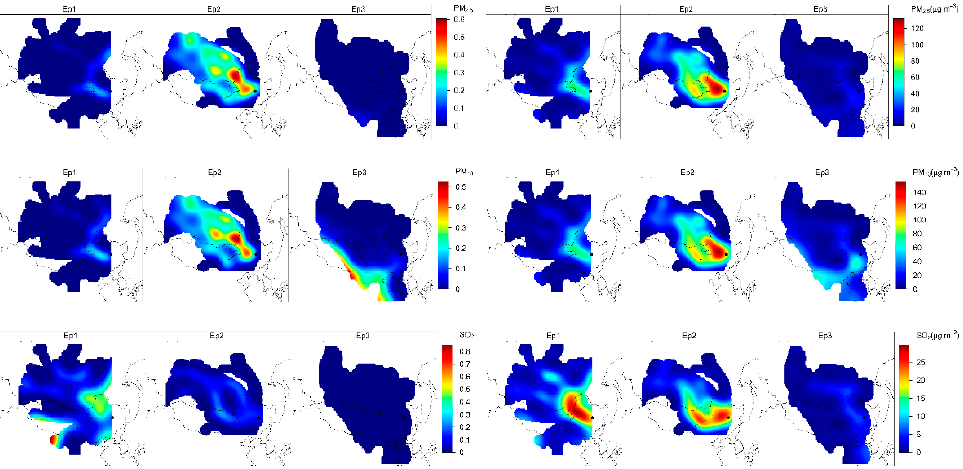
Figure 10. The 72 h backward trajectories analyzed during the three episodes and the daily contri- bution variation of each cluster. tion variation of each